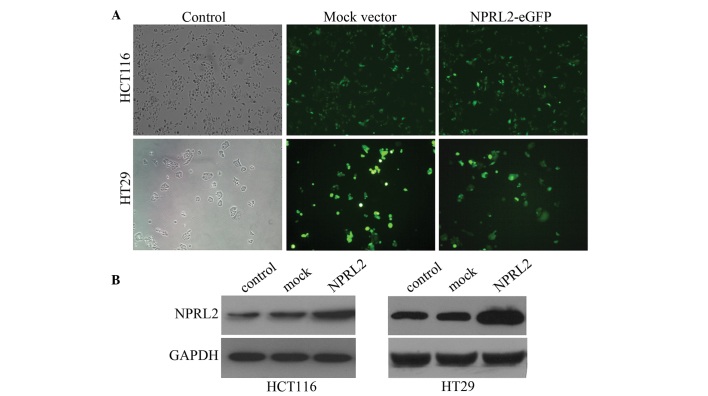
Transfection efficiency of the lentivirus. (A) Monitoring of the transfection efficiency of the lentivirus into the HCT116 and HT29 cells using a light microscope and a fluorescence microscope that measured eGFP expression (magnification, x200). (B) Protein levels of the NPRL2, determined by western blotting. NPRL2, nitrogen permease regulator-like-2; eGFP, enhanced green fluorescence protein. Control, cells without transfection; mock, cells transfected with mock vector; NPRL2, cells transfected with NPRL2-overexpression vector.